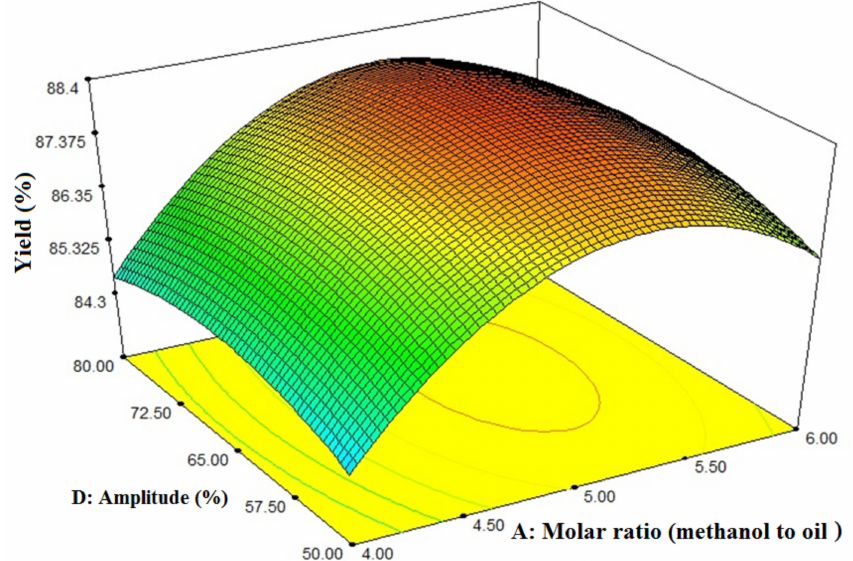
Figure 5. E ff ect of amplitude on yield (methyl ester content) at a pulse of 0.4